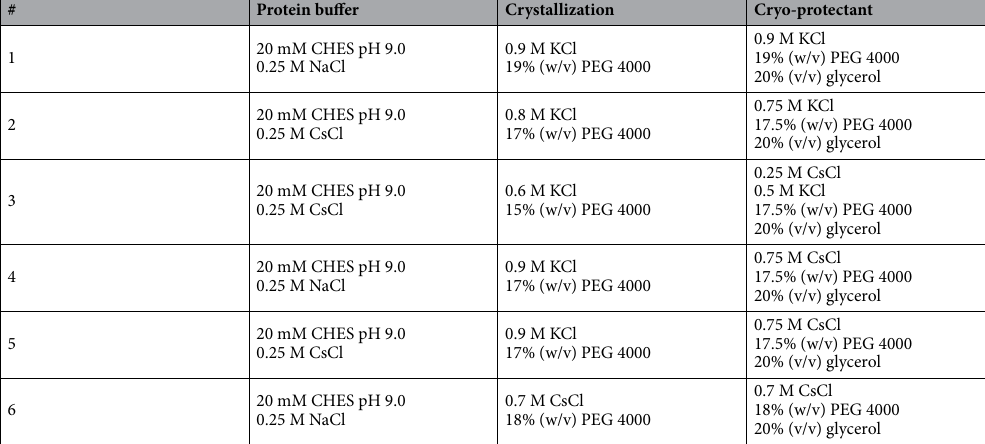
Table 6. Crystallization and cryo-protectant conditions of p62 PH